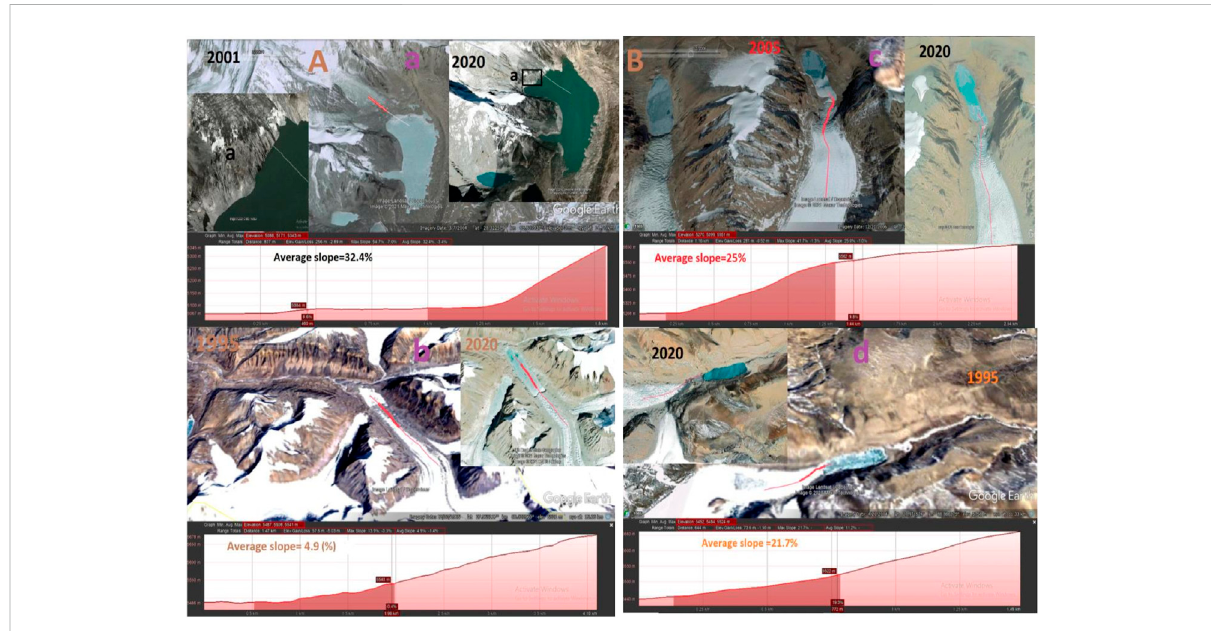
FIGURE 9 Surface slope of glaciers at lower part of ablation area, i.e., close to glacial lake. (A) Google Earth based observationsof surface slope of glaciers temporarily (A) view in 2006 shows connected and (B) shows view in 2020 which became unconnected (B) GIS based procedures for future prediction of becoming unconnected based on slope of lower part of ablation area for Sikkim Himalayan connected